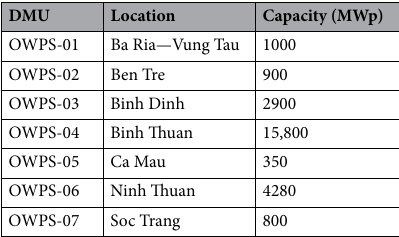
Table 13. OWPS projects in Vietnam as of 2021.